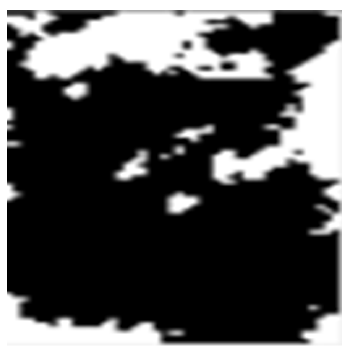
Figure 9. The binary version of the image in the yellow box.